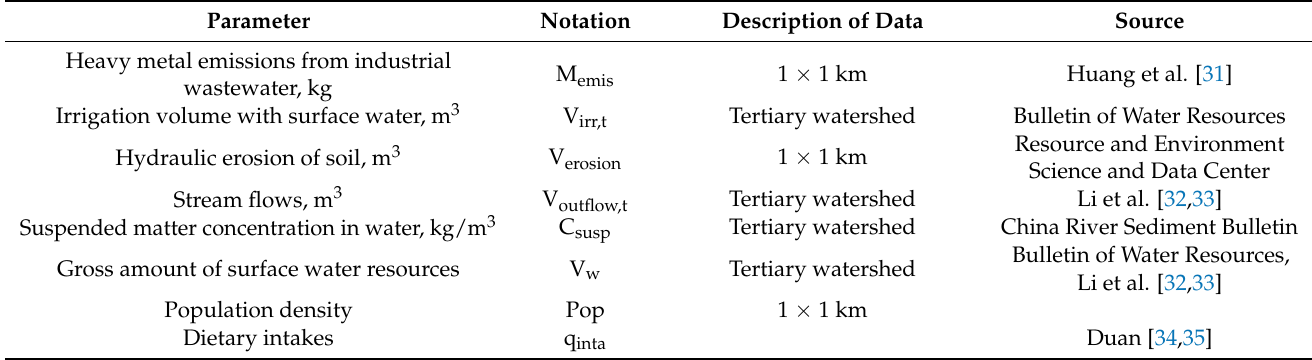
Table 2. Parameters and related data